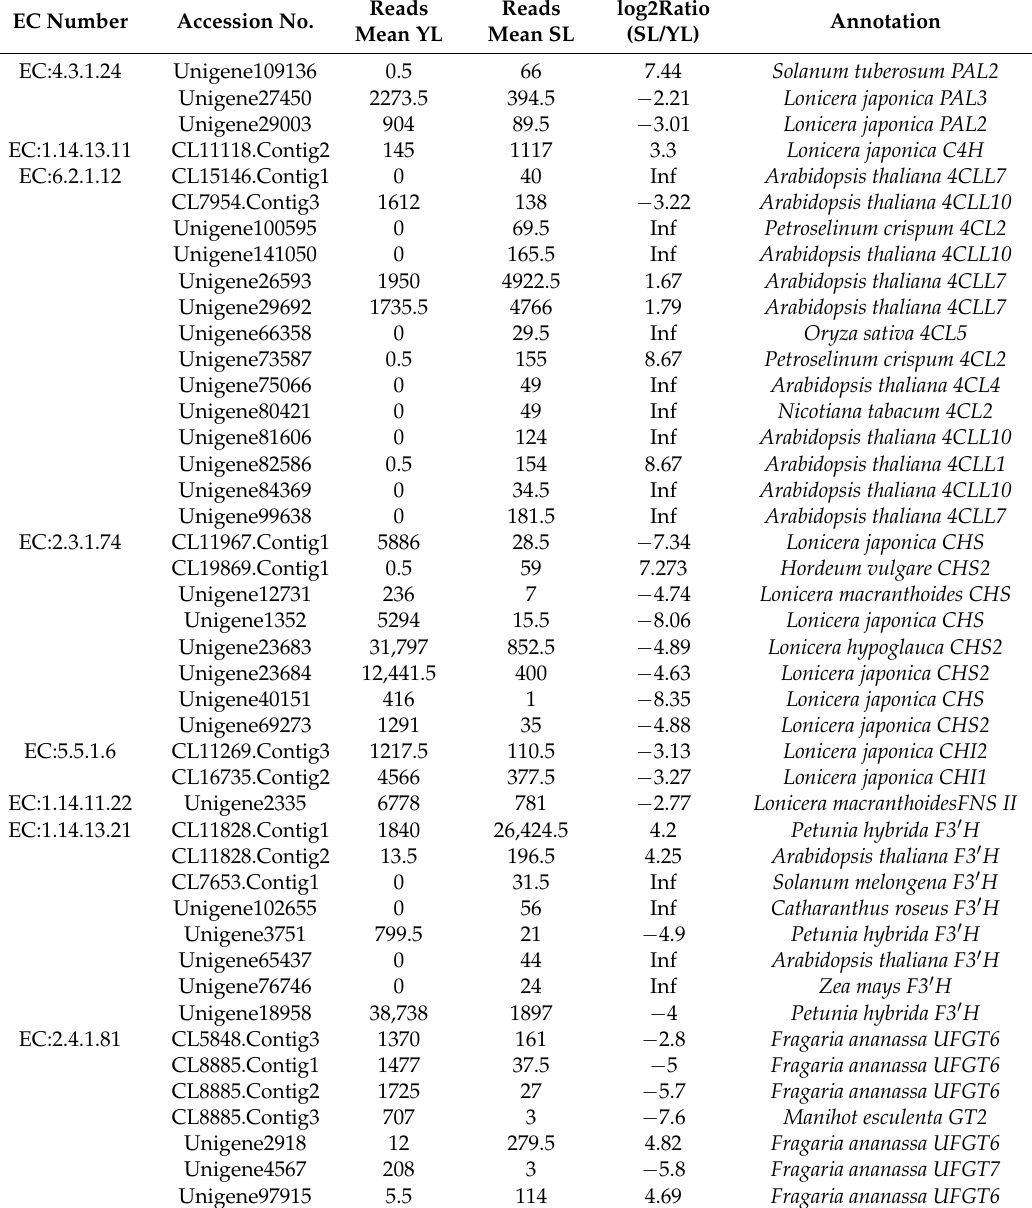
Table 2. DEGs involved in luteoloside biosynthesis during leaf senescence in Lonicera macranthoides . EC